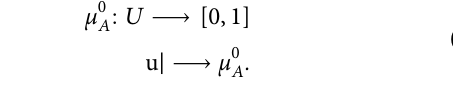
Figure 4: Diagram of opposite fuzzy